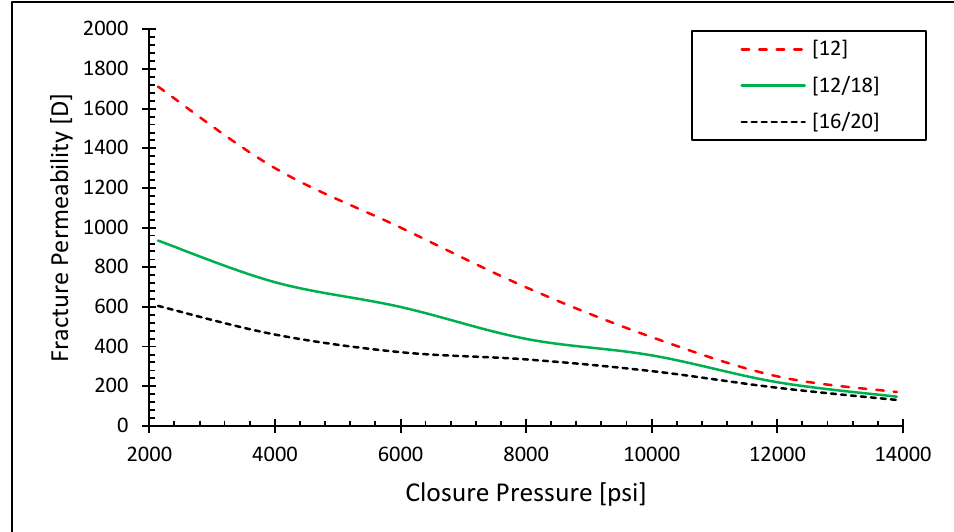
Figure 16. Fracture permeability as a function of closure pressure.